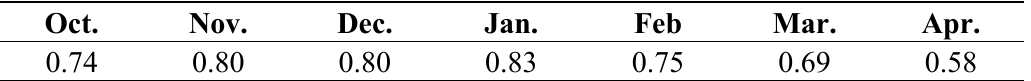
Table 5. Shading factors due to the opaque obstacles of the solar greenhouse.